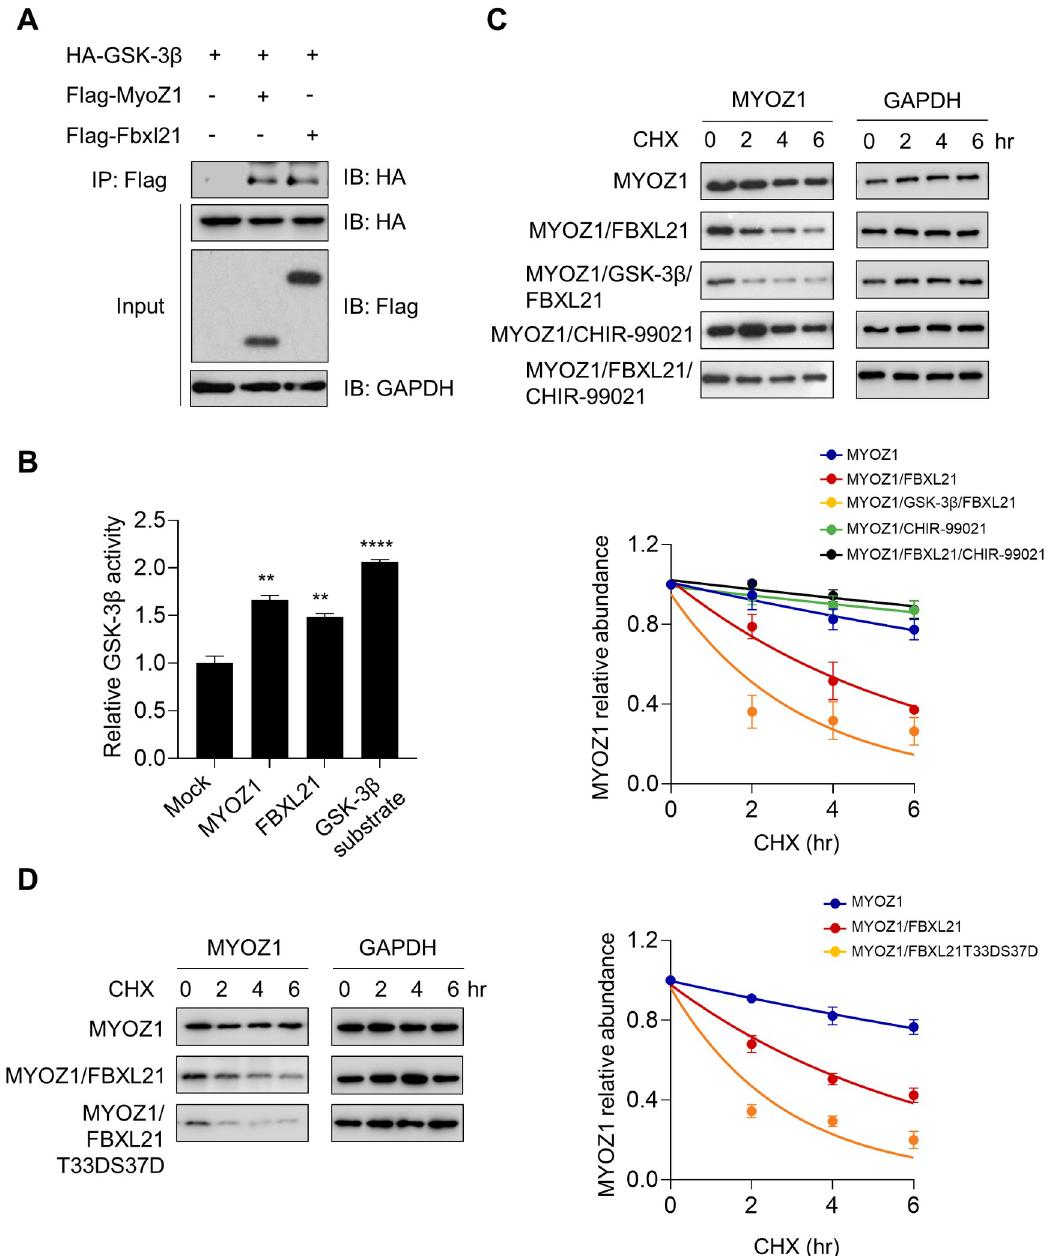
Fig 2. GSK-3 β binds to MYOZ1 and regulates FBXL21-mediated MYOZ1 degradation. (A) Interaction of MYOZ1 and FBXL21 with GSK-3 β . HEK 293T cells were co-transfected with the plasmids as indicated, and immunoprecipitation was conducted using anti-Flag antibody (M2). (B) GSK-3 β in vitro kinase assay. Affinity purified Flag-MYOZ1 and Flag-FBXL21 from 293T cells, as well as a GSK-3 β substrate peptide, were used as kinase reaction substrates. One-way ANOVA shows significant statistical differences between mock (pCMV-3XFlag empty vector) and Flag-MYOZ1, Flag-FBXL21 ( �� p < 0.01), and GSK-3 β ( ���� p < 0.0001). (C) The ectopic expression of GSK-3 β and GSK-3 inhibitor CHIR-99021 accelerated and decelerated FBXL21-mediated MYOZ1 degradation, respectively. Lower panel: quantification of the effect of CHIR-99021 on MYOZ1 stability. Data are presented as mean ± SEM (n = 3). Half-life: MYOZ1, 15.4 h; MYOZ1/FBXL21, 4.3 h; MYOZ1/FBXL21/GSK-3 β , 2.2 h; MYOZ1/CHIR-99021, 30.0 h; MYOZ1/FBXL21/CHIR-99021, 30.4 h. (D) The constitutively active FBXL21T33DS37D mutant showed enhanced E3 ligase activity for MYOZ1 degradation. Right panel: quantification of MYOZ1 degradation. Data are presented as mean ± SEM (n = 3). Half-life: MYOZ1, 15.2 h; MYOZ1/FBXL21, 4.4 h; MYOZ1/FBXL21T33DS37D, 1.9 h.